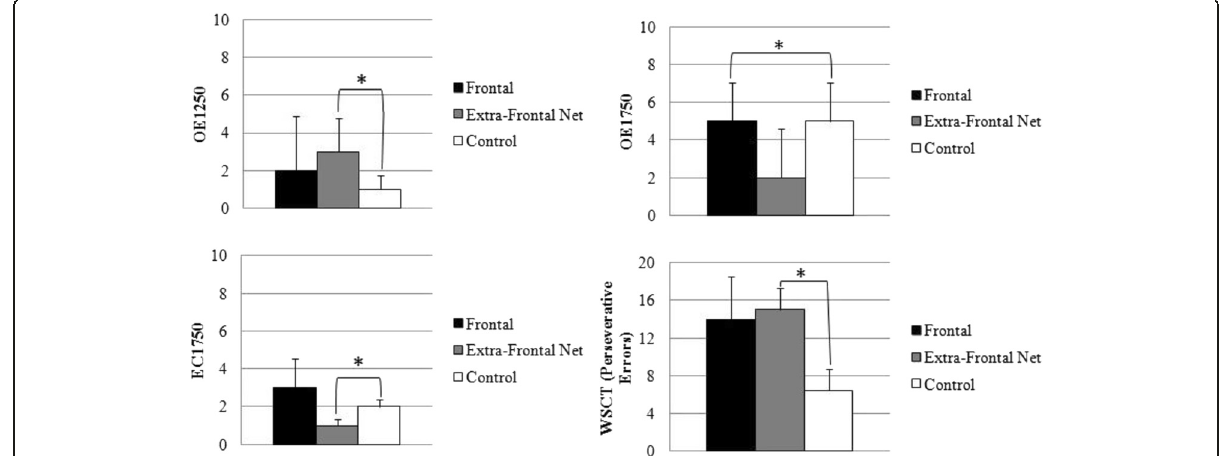
Fig. 1 Comparison among the three groups regarding impulsivity and executive functions for significative